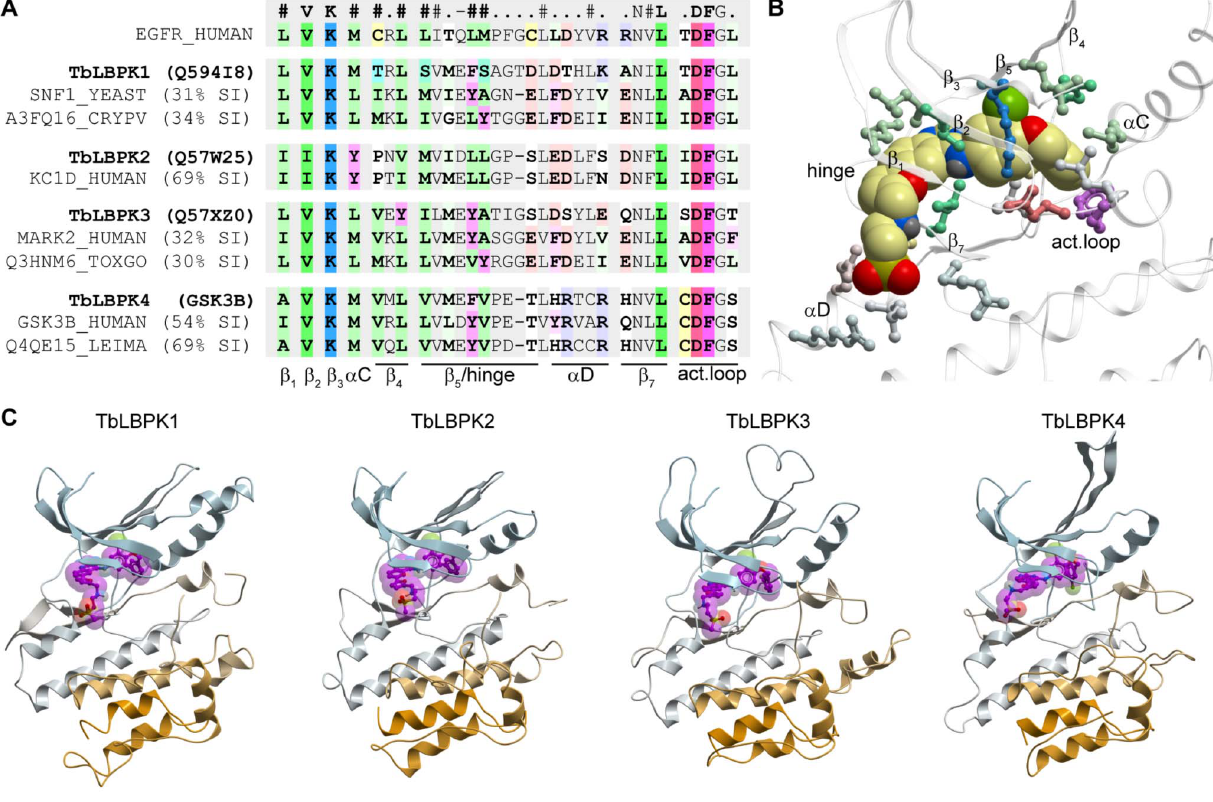
Figure 5. Homology modeling of T.brucei lapatinib-binding kinases using structures of human EGFR as templates. ( A ) Alignment of lapatinib binding site residues. ( B ) Binding site structures colored according to the alignment. ( C ) Models of TbLBPK’s1-4 complexed with lapatinib.